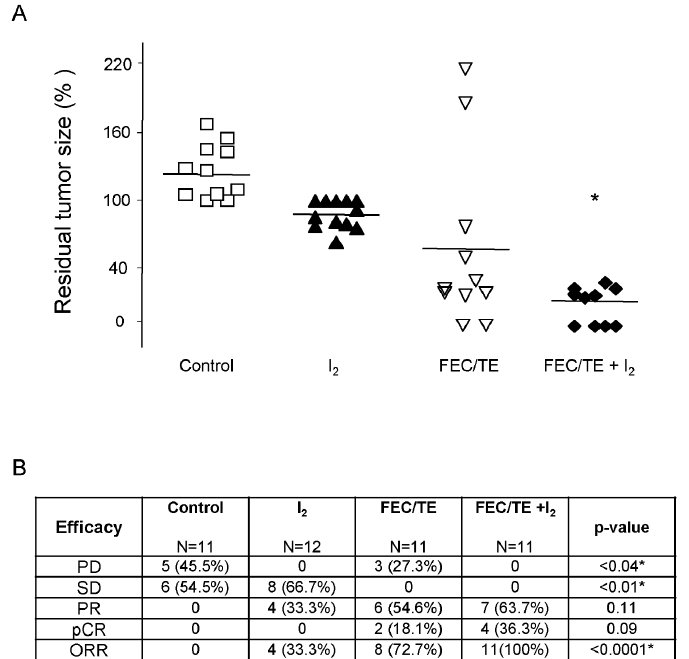
Figure 2. Tumoral response. ( A ) Changes in tumor size (%) between the first diagnostic (mammography) and final tumor size (surgery day). Dots represent individual patients. * P < 0.05, between the FEC/TE + I 2 group and all other groups. ( B ) Response evaluation criteria in solid tumors (RECIST); PD, progressive disease; SD, stable disease; PR, partial response; pCR, pathologic